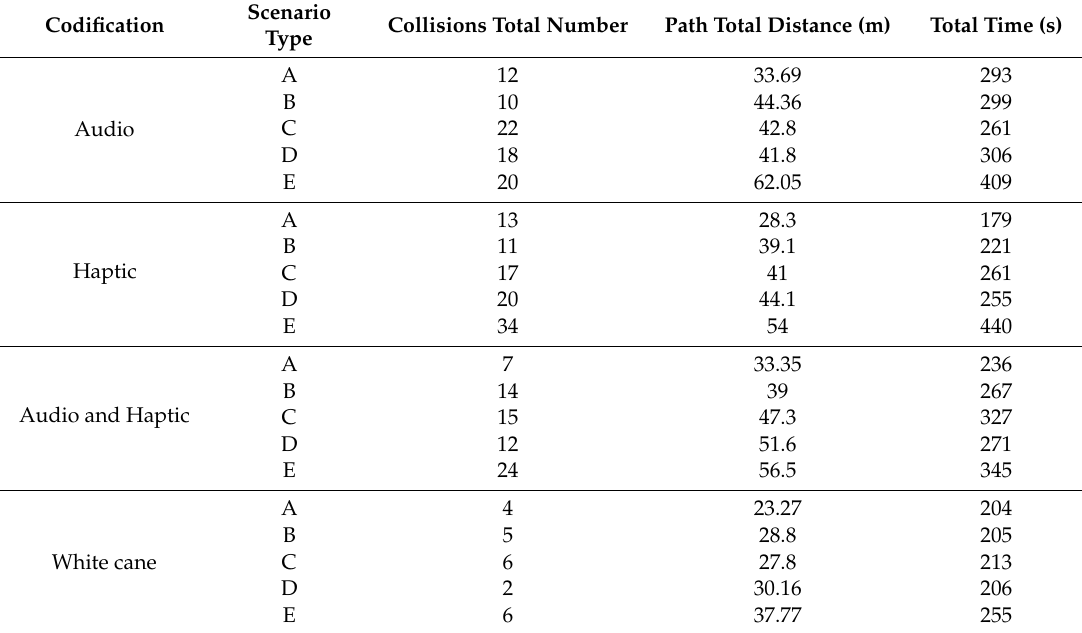
Table 1. Cumulative experimental data for the treasure hunt (TH) tasks—navigation with the Sound of Vision (SoV) device and white